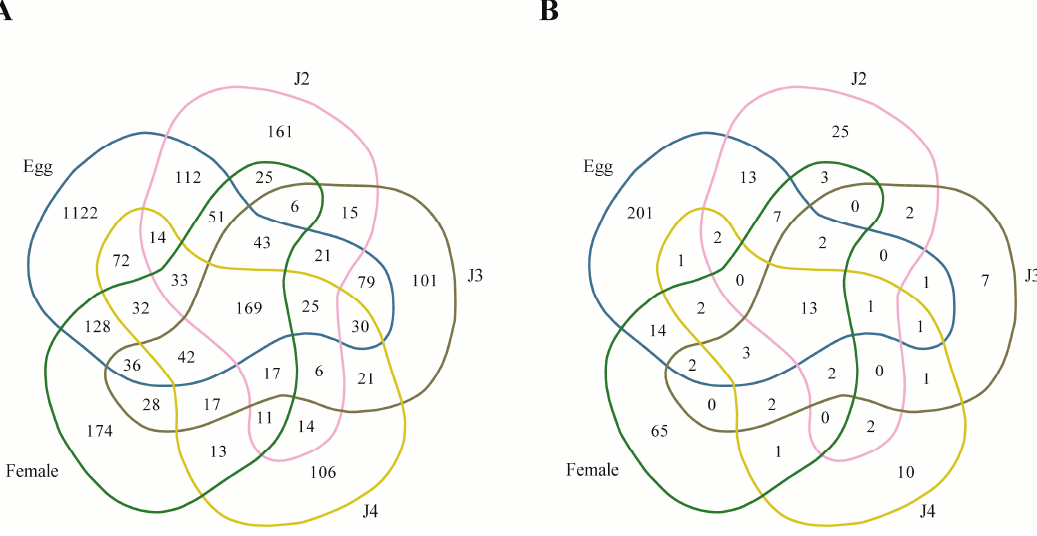
Figure 6. Distribution of miRNA expression across stages of the M. incognita life cycle. ( A ) Known miRNA (2724); and ( B ) novel miRNA (383).